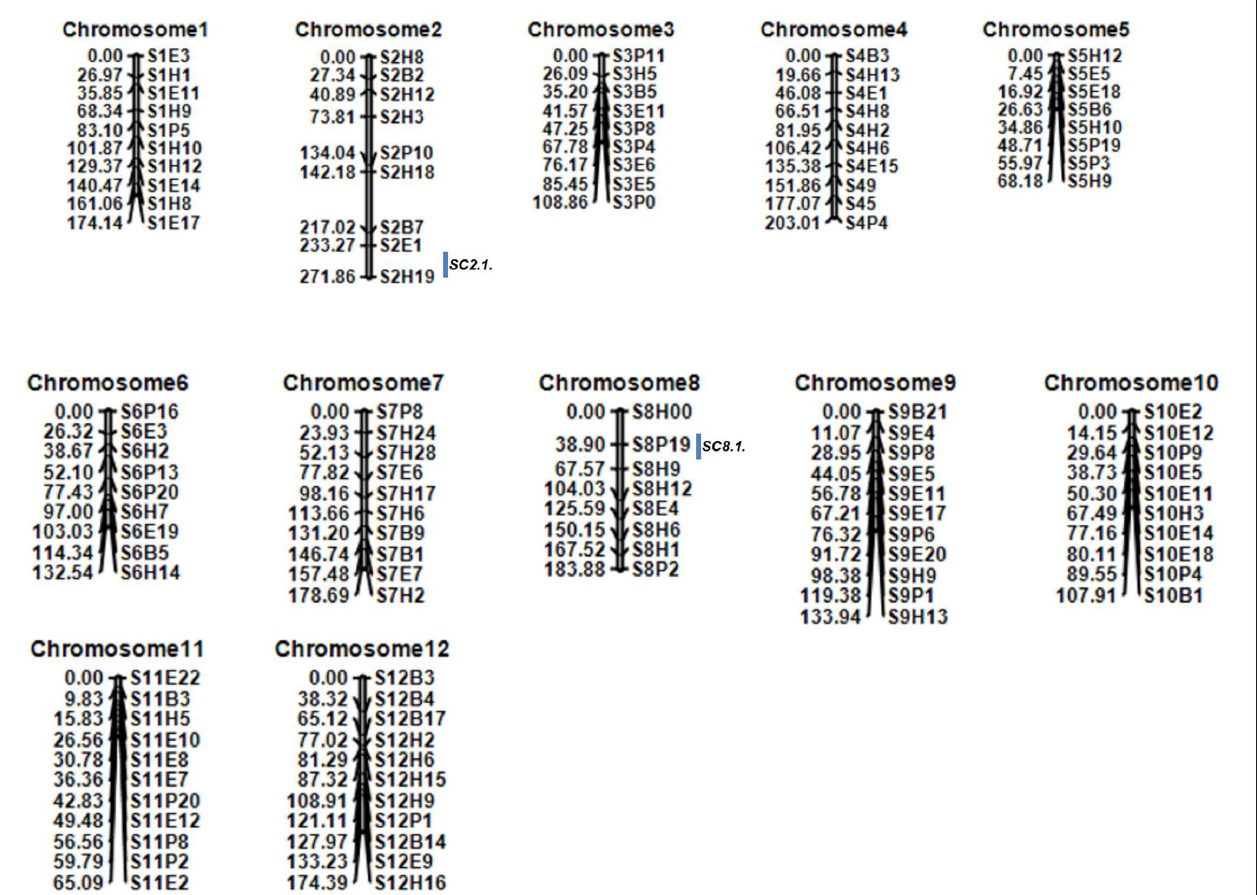
FIGURE 3 | A constructed linkage map of melon chromosomes based on the F 2 mapping population of a cross between parental lines “MR-1 and M4-7.” The box to the right of the chromosomes indicates the stable quantitative trait loci (QTL) identified as associated with stigma color by 2 years of data.